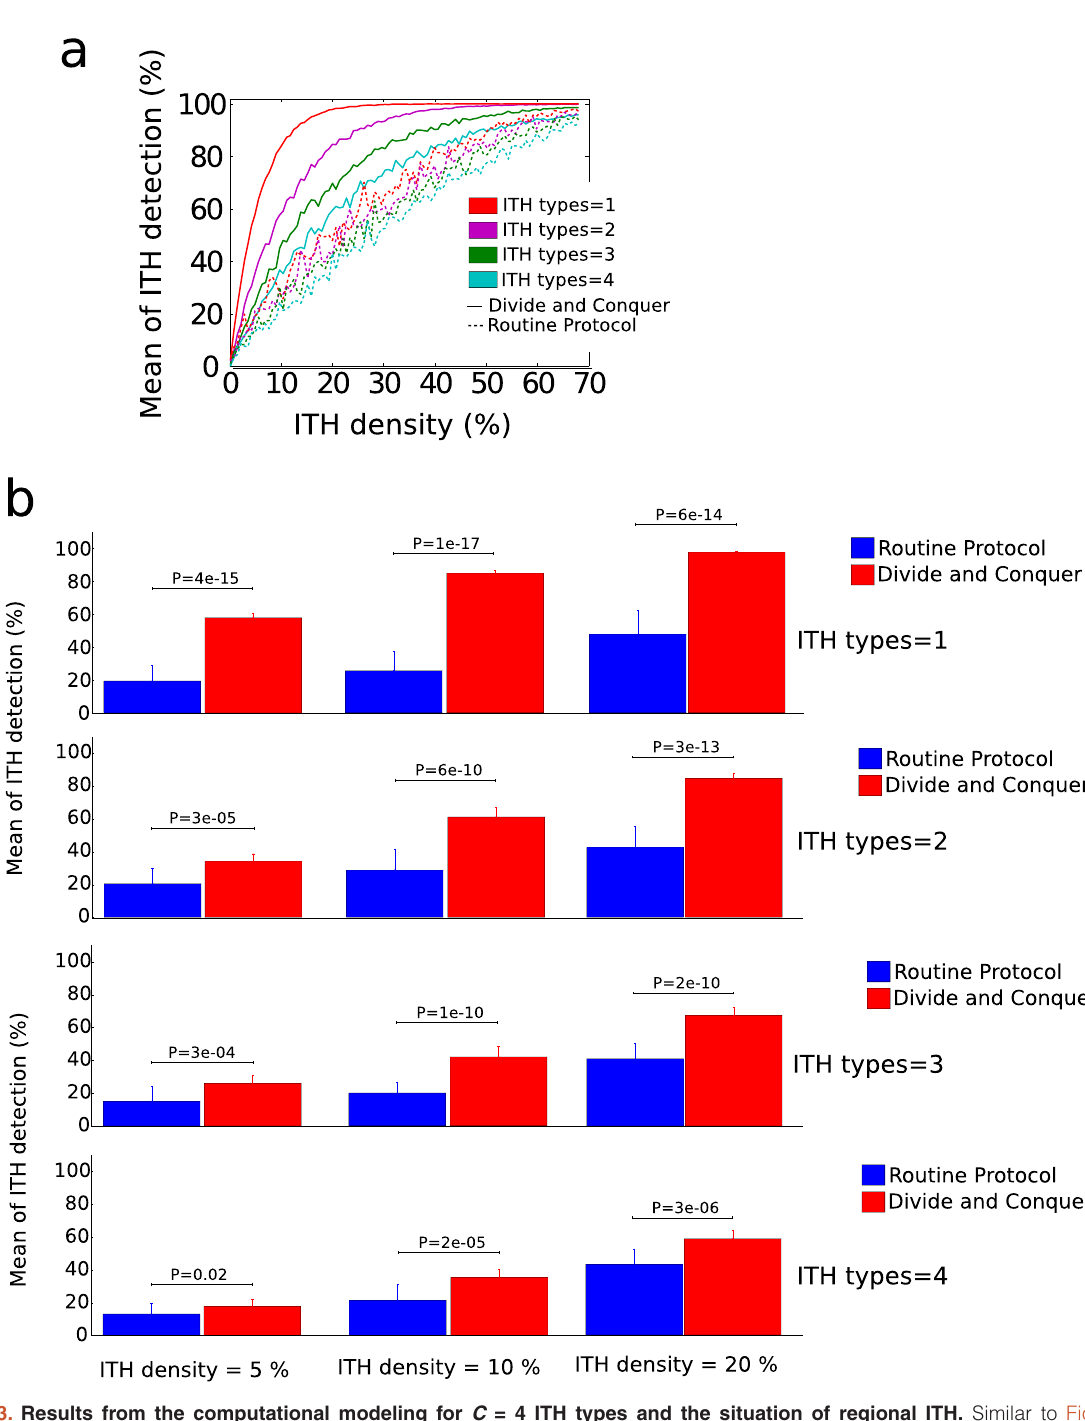
Figure 3. Results from the computational modeling for C = 4 ITH types and the situation of regional ITH. Similar to Figure 2 for C = 1, DAC performed equally as RP for random ITH (not visualised). a : regional ITH, DAC plotted as solid lines, RP as dashed ones. Different colors correspond to different ITH types. The mean of ITH detection (measured in %) is represented as function of the ITH density (also in %). Notice that, for the simulations we have performed here, DAC performed better in detecting all the C = 4 ITH types in comparison to the performance that RP achieved when only 1 ITH type existed. b : P-values after t-test (as implemented in Matlab, function ttest ) showing significant differences in performance between DAC (blue) and RP (red) for different values of ITH